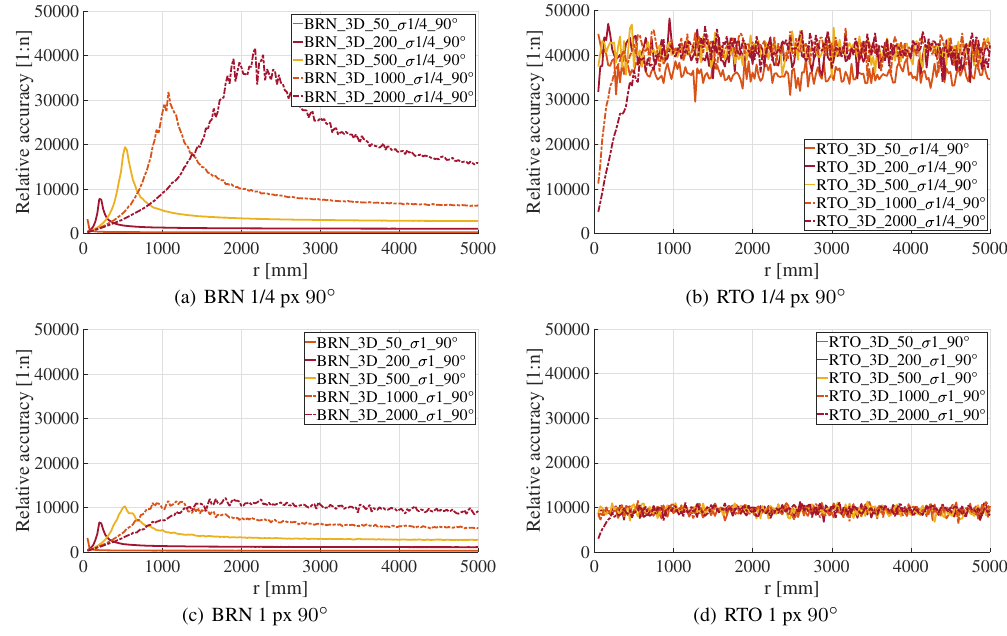
Figure 5. Relative accuracy of noise data of 3D data set with 90 ◦ angle (equals combination of red lines in Fig. 4 b, d, f, h, j) for implicit modeling (left) and explicit ray tracing (right). Standard deviation per coordinate was set to 1/4 px (top) and 1 px (bottom).